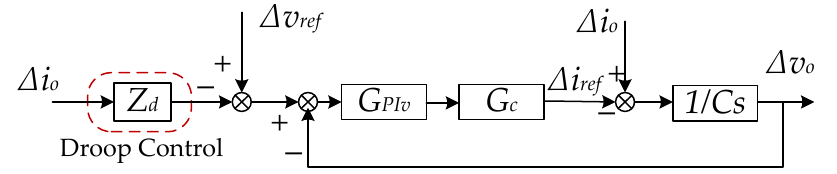
Figure 5. Small signal control block diagram of droop control.